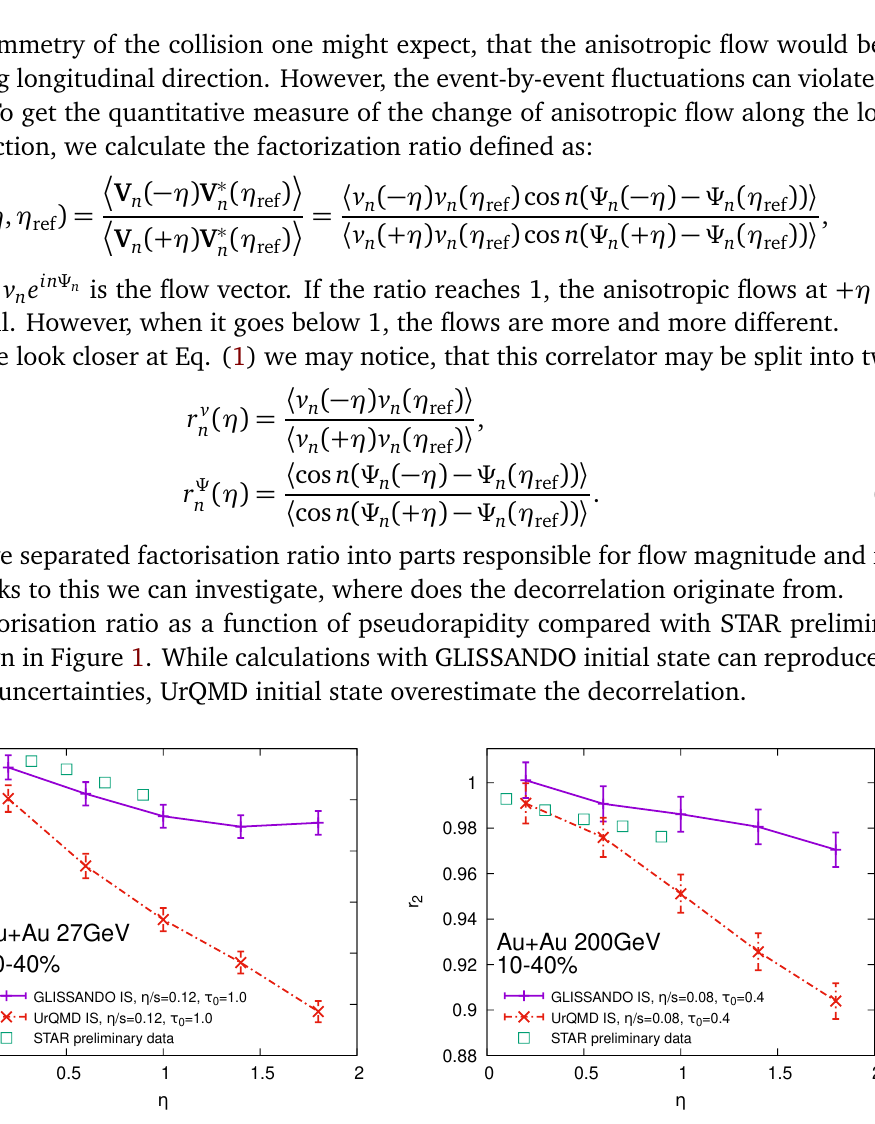
for 10 − 40% Au-Au 2